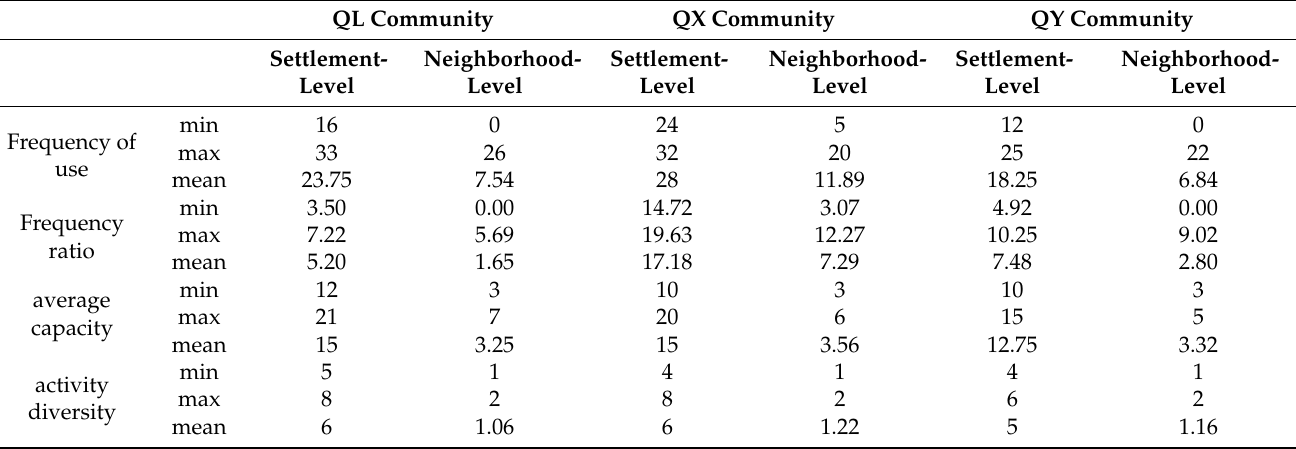
Table 3. Summary of frequency of use, mean capacity and activity diversity data of public space nodes for affordable housing samples.